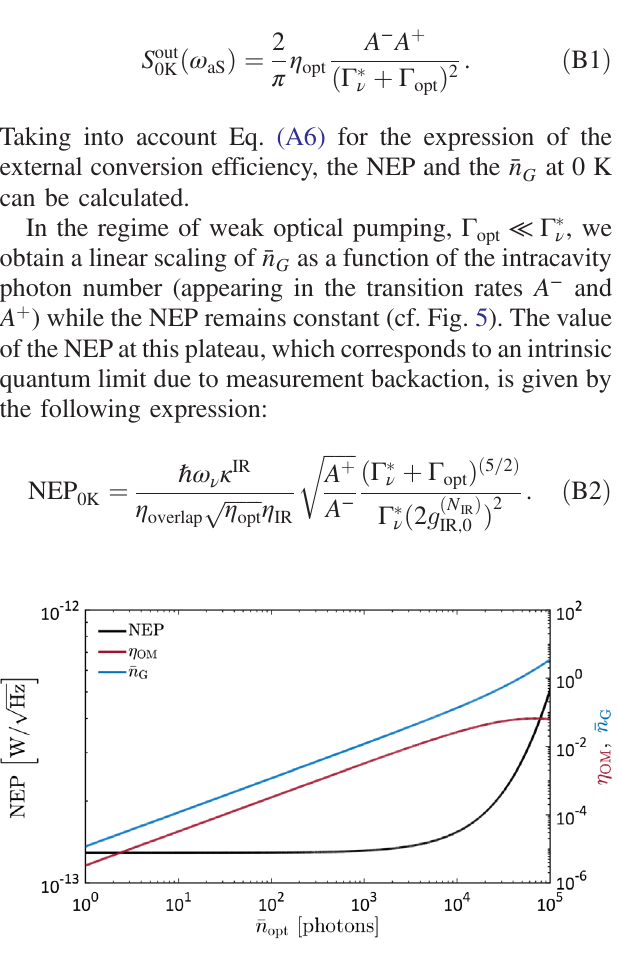
FIG. 5. Zero-temperature quantum limit on the NEP. NEP (black solid line, left axis), power-dependent part of the internal con- version efficiency ( η , red solid line, right axis), and noise- OM equivalent photon number per gate ( ¯ n , blue solid line, right axis) G asafunctionoftheintracavityopticalphotonnumberfor Δ ¼ − ω ν . The parameters used here are described in the